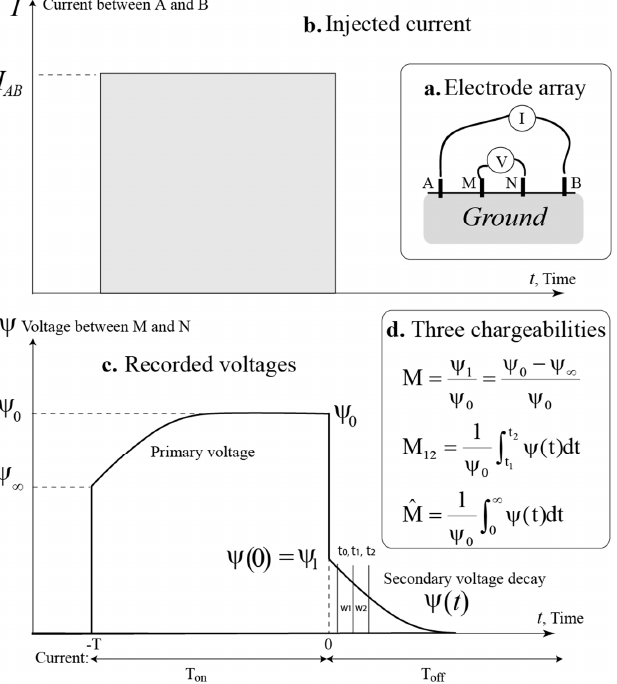
Figure 1. Time-domain induced polarization. ( a ) The electrode array includes two current electrodes (A and B) and two voltage electrodes (M and N) connected to a high-impedance (>100 MOhm) voltmeter. ( b ) Injected current ( T on is the period). ( c ) Recorded difference of potential between M and N. The buildup of the voltage and the decay of the secondary voltage are symmetrical. We distinguish an initial voltage buildup ( ψ ∞ ) (instantaneous potential), which defines the instantaneous conductivity ( σ ∞ ), and a steady-state or direct-current (DC) voltage buildup ( ψ 0 ), which defines the DC conductivity ( σ 0 ). ( d ) The definition of three chargeabilities are given: a total chargeability ( M ) (dimensionless), and a partial chargeability ( M 12 ) (in s), which is defined for a given time window during the decay of the secondary voltage. M = M 12 when the times are small with respect to the relaxation time ( τ ). The time from 0 to t 0 is called the “dead-time”. Finally, an “integral chargeability” can be obtained by integrating the decay voltage